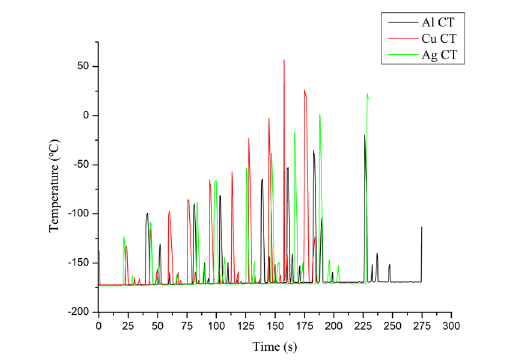
Figure 2. Temperature variation during CT rolling processes for Al, Cu and